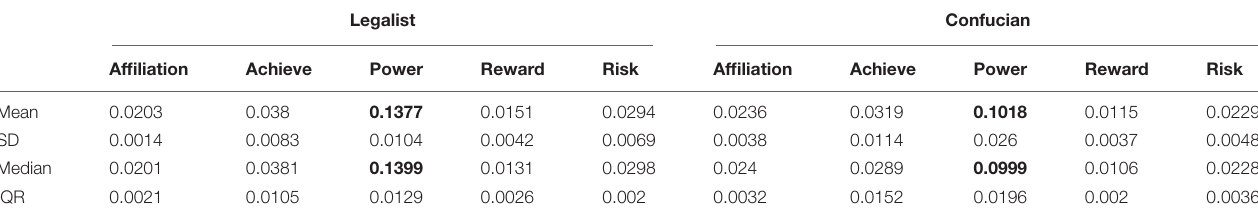
TABLE 4 | Statistics of the frequencies of each word category in Confucian and Legalist books. Legalist